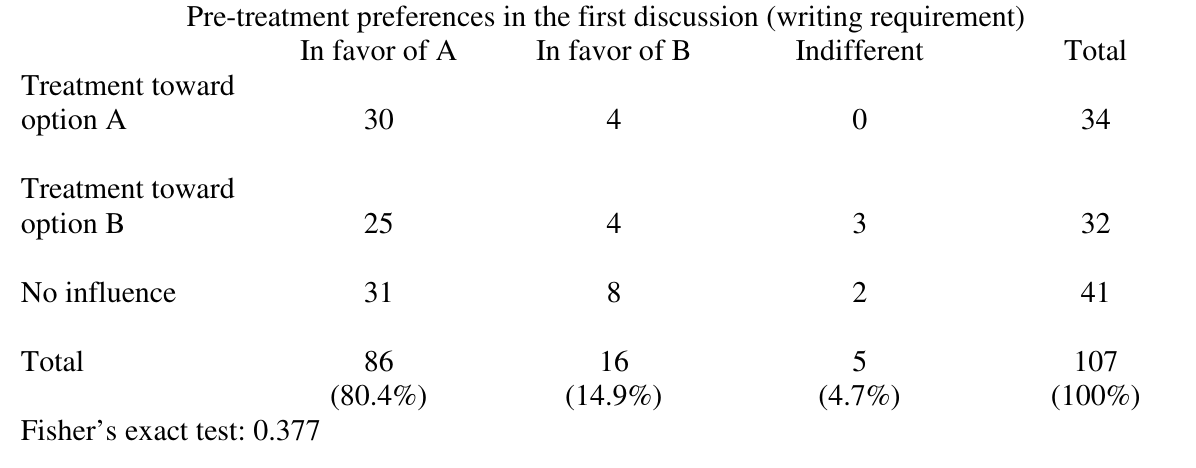
Table A5: Pre-discussion preferences and randomization checks Pre-treatment preferences in the first discussion (writing